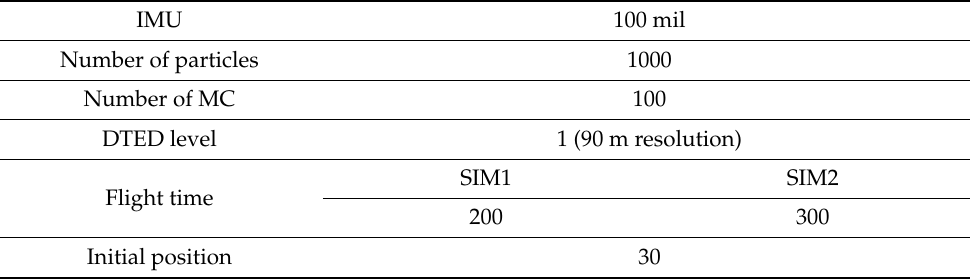
Table 2. Simulation parameters.